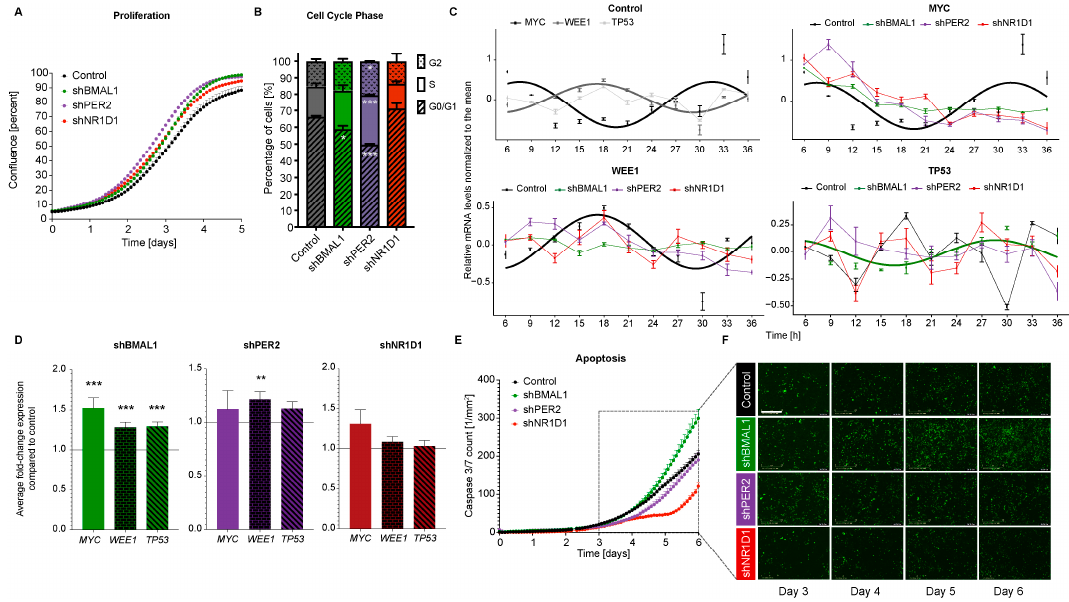
Figure 2. Core-clock gene knockdown affects cell proliferation in HCT116 cells. ( A ) Proliferation analyses of HCT116 cell lines after shRNA) knock-down of core-clock genes ( BMAL1 , PER2 and NR1D1 ) over 5 days ( n > 8, mean ± SEM, p < 0.001 for shBMAL1 , shPER2 and sh NR1D1 comparing AUC to control, two-tailed unpaired t-test). ( B ) Cell cycle phase distribution of KD cell lines compared to control ( n = 3, mean ± SEM, no asterisk p > 0.05, * p < 0.05, *** p < 0.001; two-tailed unpaired t-test). ( C ) 30-hour time-course gene expression analysis for MYC , WEE1 and TP53 in different HCT116 KD cells ( n = 3, mean ± SEM, a cosine curve was fitted to all data sets and displayed as a full line for p < 0.05, the data points were connected with closed lines if p > 0.05). ( D ) The average expression level for MYC , WEE1 and TP53 in each KD cell line compared to the control ( n = 3, mean ± SEM, no asterisk p > 0.05, * p < 0.05, ** p < 0.01, *** p < 0.001; two-tailed unpaired t -test). ( E ) Apoptosis analysis of HCT116 cell lines after shRNA KD of BMAL1 , PER2 and NR1D1 ( n > 8, mean ± SEM, p < 0.05 for shBMAL1 and shNR1D1 , two-way ANOVA and corrected for multiple testing using Benjamini and Yekutieli method. Measurements obtained by counting caspase3 / 7 green objects per mm 2 every 2 h in the course of 6 days using the IncuCyte S3 device. ( F ) Representation of the apoptosis assay using the IncuCyte S3 software over the course of 6 days. Green dots represent apoptotic cells expressing caspase3 / 7. Scale bar: 500 µm.